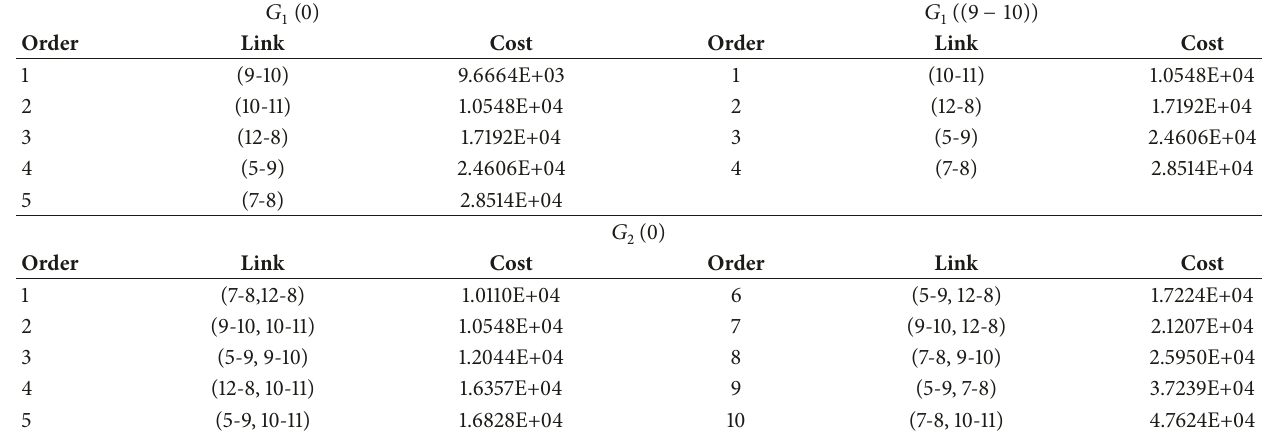
Table 2: Feasible solutions of the first stage of the optimal maintenance scheme.